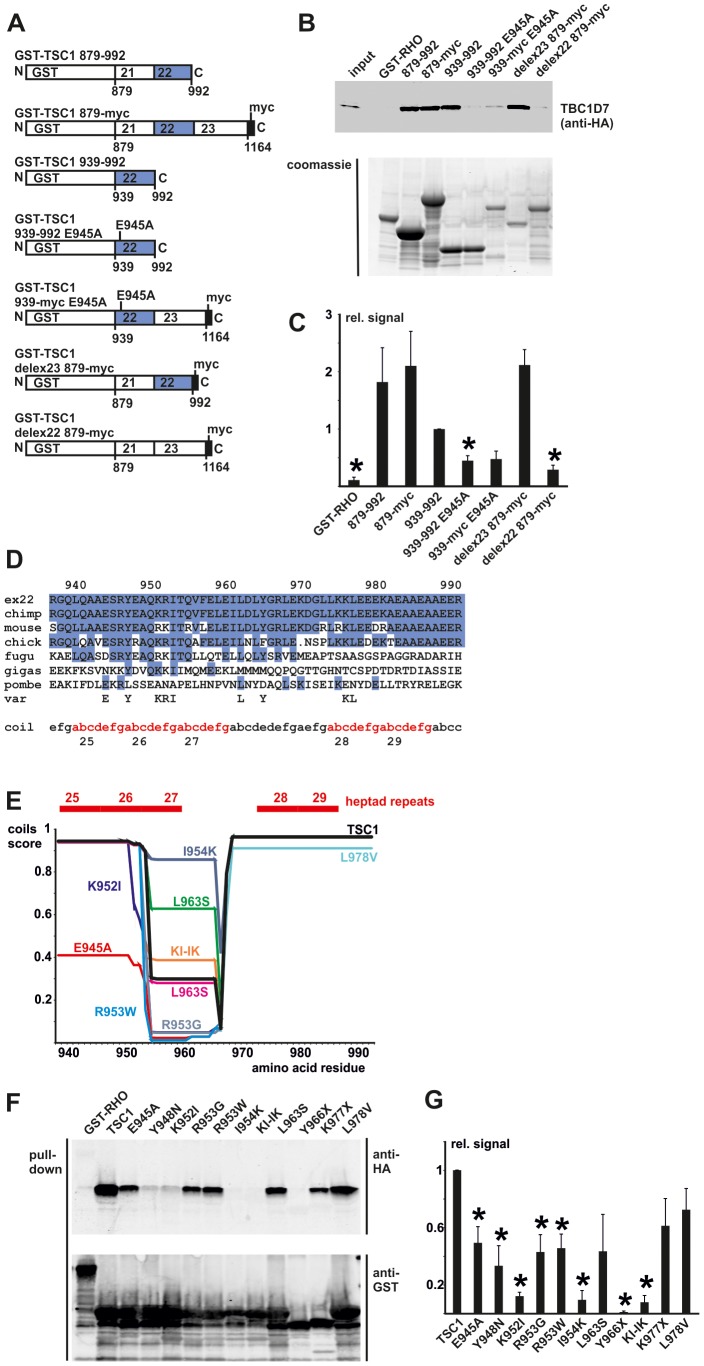
TSC1 amino acids 939 – 977 are sufficient for binding TBC1D7.HA-TBC1D7 was expressed in transfected HEK 293T cells. Glutathione-S-transferase (GST) TSC1 fusion proteins were expressed in E. coli and purified on glutathione-agarose beads. Interactions between TBC1D7 and the GST-TSC1 fusion proteins were assayed by glutathione bead pull-down followed by immunoblotting. A. Overview of the GST-TSC1 fusion proteins. Sequences corresponding to exon 22 are shaded; the E945A substitution and myc-tag are indicated. B. Pull-down using the GST-TSC1 fusion proteins. Upper panel: immunoblot of HA-TBC1D7 retained on the glutathione-GST-TSC1 fusion protein beads. Lower panel: coomassie staining of the purified GST-TSC1 proteins. C. The integrated intensities of the immunoblot signals for bound TBC1D7 were quantified relative to the GST-TSC1 939–992 fusion protein (939 – 992 = 1) in at least 3 independent experiments. TBC1D7 was retained significantly less effectively by GST fusion proteins lacking amino acids 939 – 992 (GST-RHO or delex22 879-myc) (unpaired t-test p values<0.05; indicated with asterisks). Error bars indicate the standard error of the mean. D. Conservation of residues corresponding to TSC1 exon 22. The human (ex22), chimpanzee (chimp), mouse, chicken (chick), pufferfish (fugu), fruit fly (gigas) and fission yeast (pombe) sequences are shown. Identical residues are highlighted. Amino acids tested for their involvement in binding TBC1D7 are given (var). Heptad repeats 25 – 29 are indicated in red (coil). E. Predicted effects on the TSC1 coiled coil region according to the COILS server. Coils probability scores calculated for a 28 residue window (default conditions) are shown for each variant (colour), compared to the wild-type sequence (TSC1; black). Heptads 25 – 29 are indicated in red. F. Pull-down using GST-TSC1 exon 22 fusion proteins. Binding of TBC1D7 to wild-type GST-TSC1 939–992 (TSC1) was compared to GST-RHO and 11 different TSC1 variants (E945A, Y948N, K952I, R953G, R953W, I954K, KI-IK (K952I-I954K double variant), L963S, Y966X, K977X and L978V). Upper panel: immunoblot of HA-TBC1D7 retained on the glutathione-GST fusion protein beads. Lower panel: immunoblot of the purified GST-TSC1 fusion proteins. G. The integrated intensities of the immunoblot signals for bound TBC1D7 were quantified relative to wild-type GST-TSC1 939–992 (TSC1 = 1) in at least 3 independent experiments. TBC1D7 was retained significantly less effectively by the E945A, Y948N, K952I, R953G, R953W, I954K, KI-IK and Y966X variants (unpaired t-test p values<0.05; indicated with asterisks). Error bars indicate the standard error of the mean.